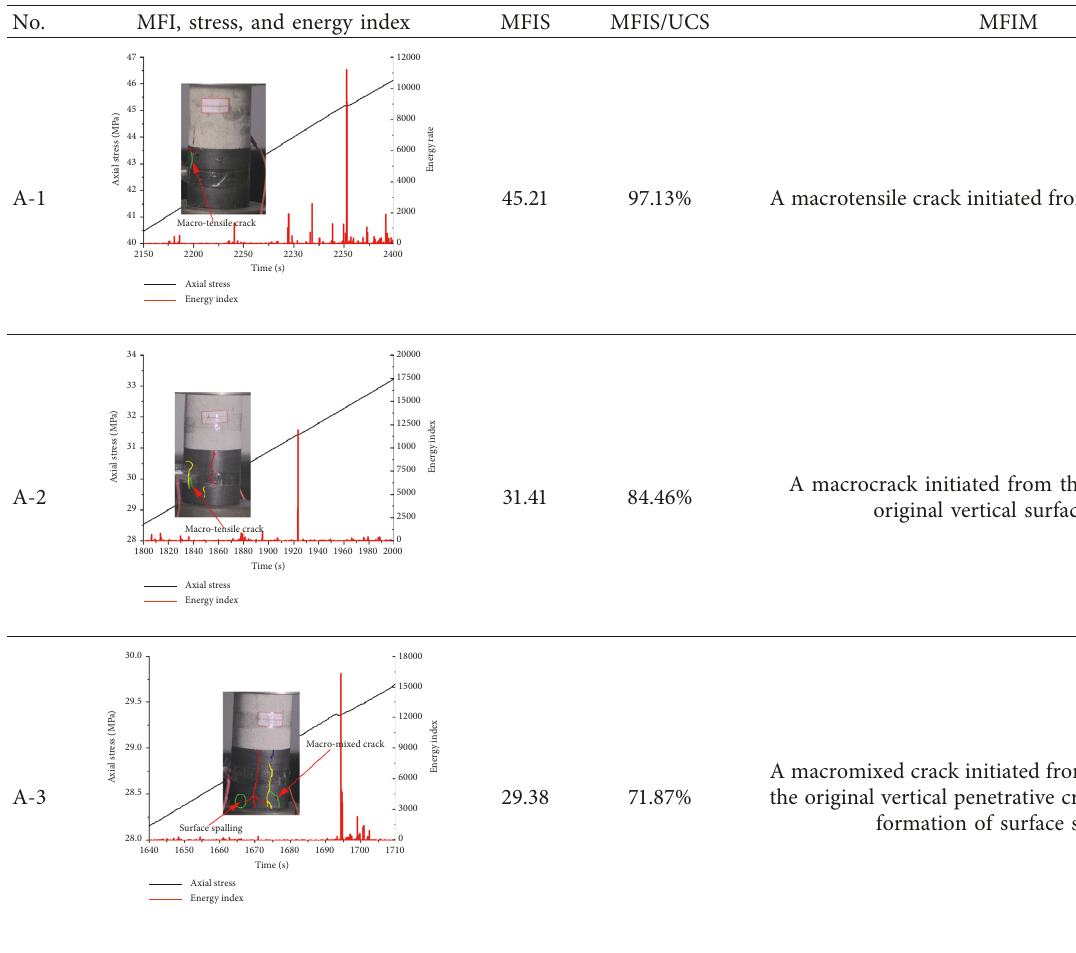
Figure 5: Macrofailure initiation of the rock-coal composite sample [5]. Table 3: MFIS, energy index peak caused by the MFI, and